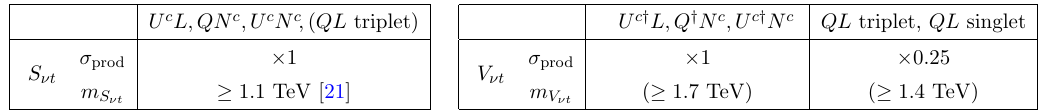
Table 4 . 95% CL lower limits on the masses of MLQs which decay into ( (cid:23)t )( (cid:23)t ) (cid:12)nal states for scalar LQs ( left ) and vector LQs ( right ).